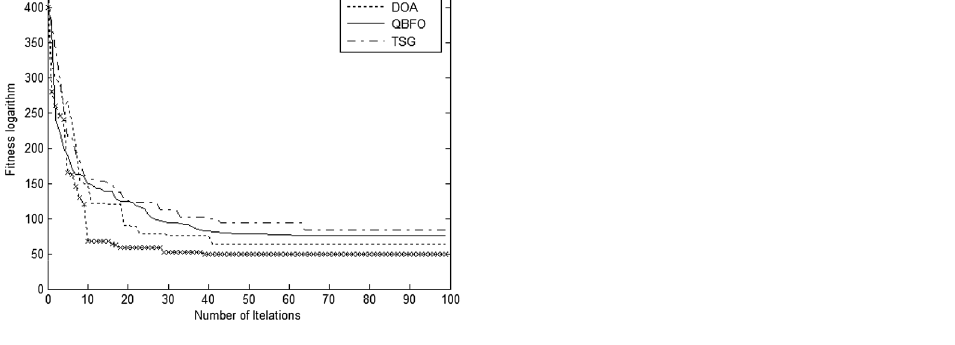
Figure 2. The fitness convergence curve of 4